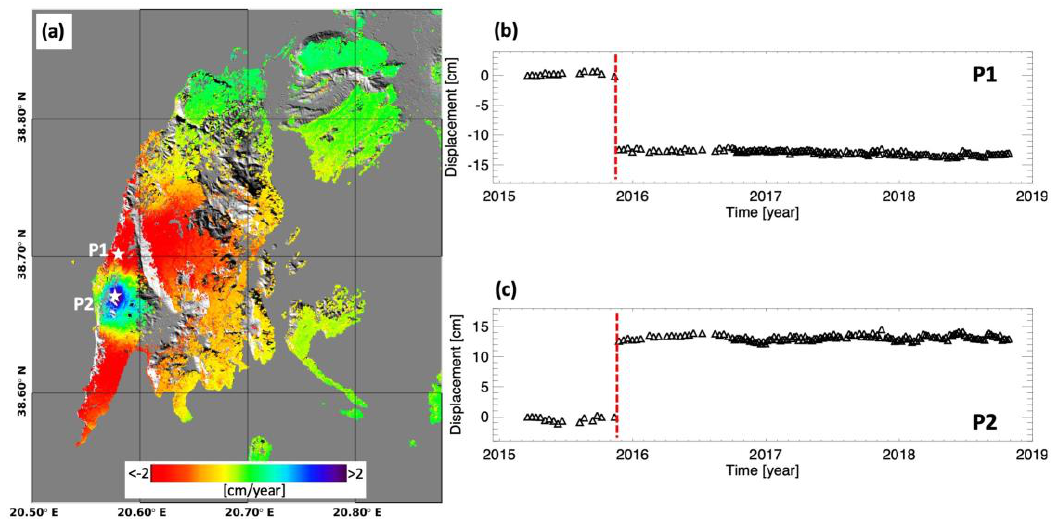
the maximum uplift zone and identified by the white dashed line in panel ( a ).